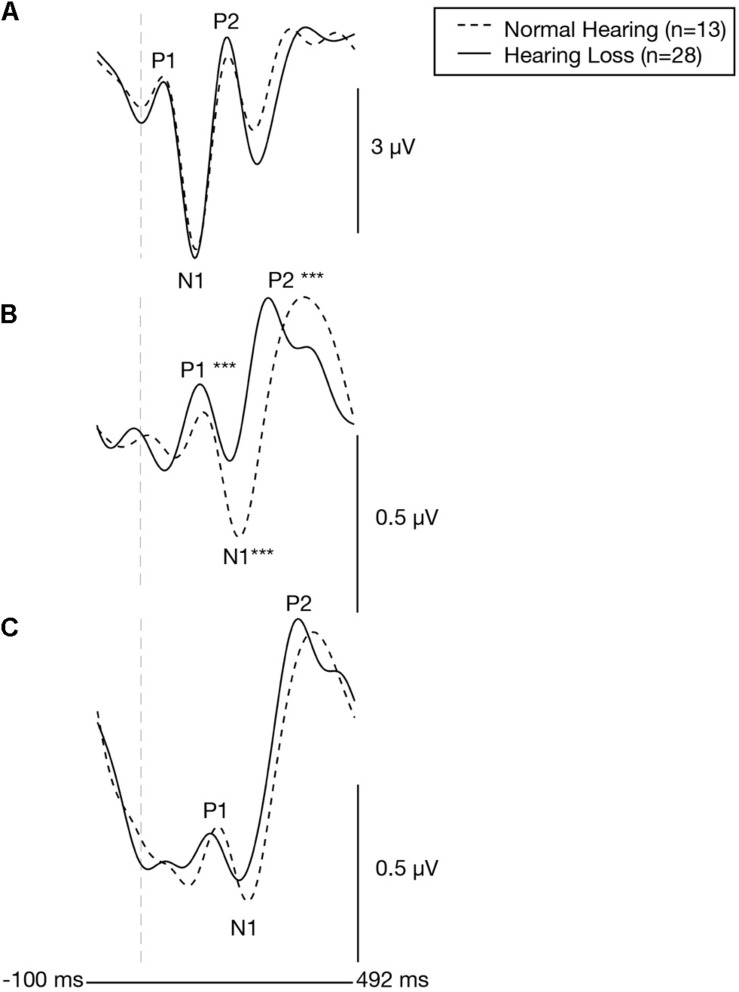
Baseline group differences in cortical visual evoked potentials across an occipital, right temporal, and left temporal region of interest. Grand-averaged CVEP waveforms for the normal hearing group (n = 13) and the age-matched group of adults with early-stage, age-related hearing loss (n = 28) are depicted for the occipital region of interest (A), the right temporal region of interest (B), and left temporal region of interest (C). Time (milliseconds) is displayed on the horizontal axis and amplitude (μV) is displayed on the vertical axis. Asterisks show level of significance (***p ≤ 0.001) for differences in CVEP latencies between the two groups. The hearing loss group showed significantly earlier CVEP P1, N1, and P2 latencies over the right temporal region compared to the normal hearing group.